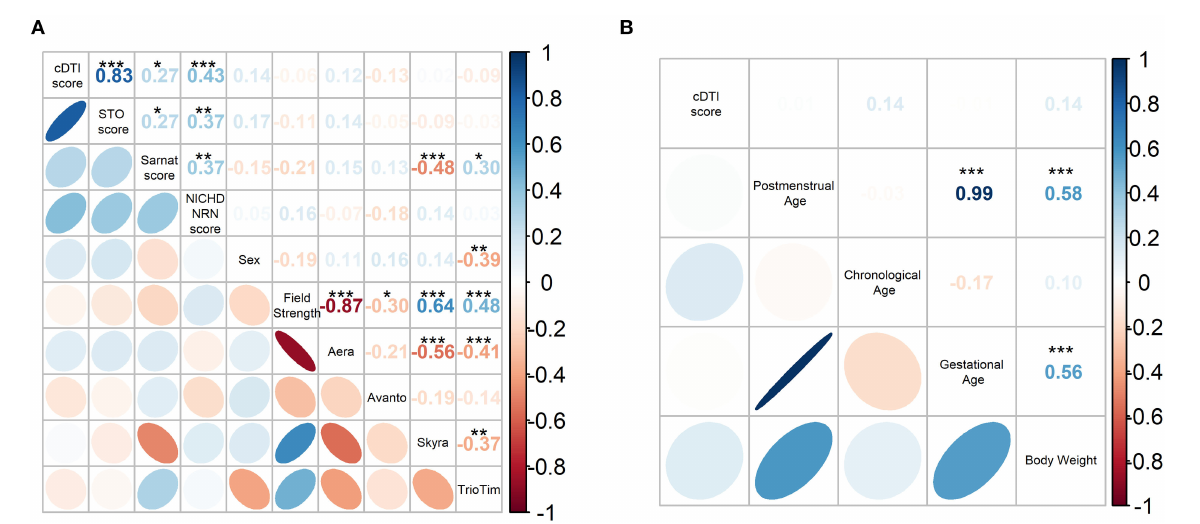
FIGURE4 (A) Spearman’s correlation coefficient matrix between the cDTI score and categorical clinical variables (i.e., STO, Sarnat, NICHD-NRN, sex, field strength, scanner preference). (B) Pearson’s correlation coefficient matrix between the cDTI scores and numerical variables (postmenstrual age, chronological age, gestational age, and weight). Color-coded numbers in the upper right half of the matrix indicate correlation coefficients ( * p < 0.05, ** p < 0.01, and *** p < 0.001, blue: positive coefficient, red: negative coefficient). The color-coded ellipses in the lower left half of the matrix indicate the strength of correlation between variables, with blue indicating a negative correlation and red indicating a positive correlation. The shape of the ellipses indicates the strength of the correlation (ellipses are sharp when the correlation is strong and round when it is weak), positive slope indicates a positive correlation, and negative slope indicates a negative correlation.